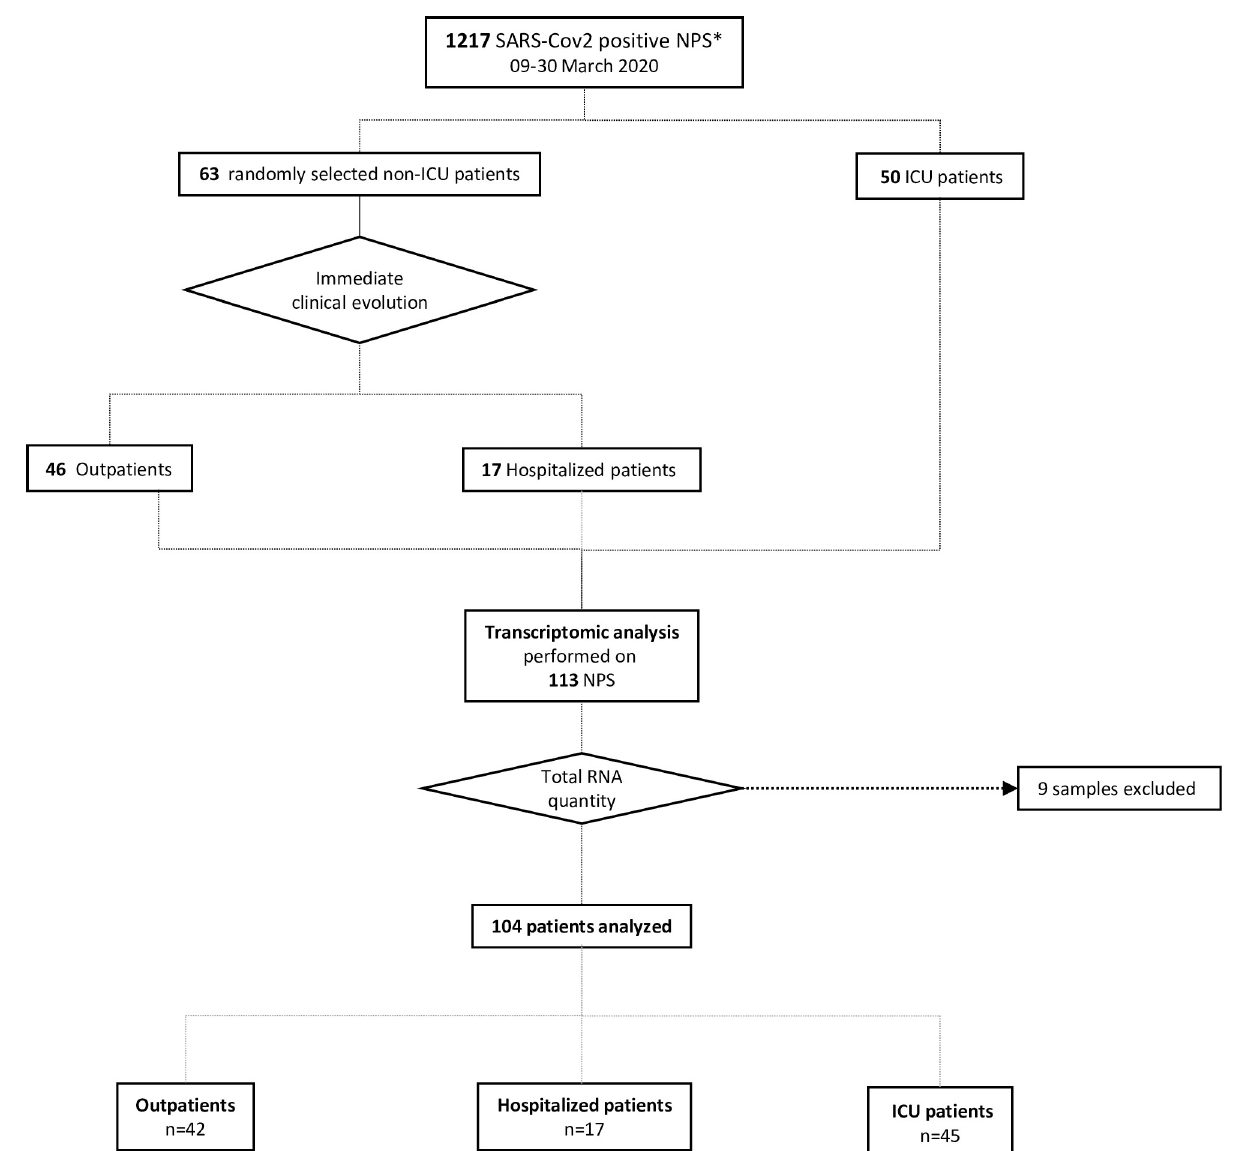
Fig 1. Flow chart of the